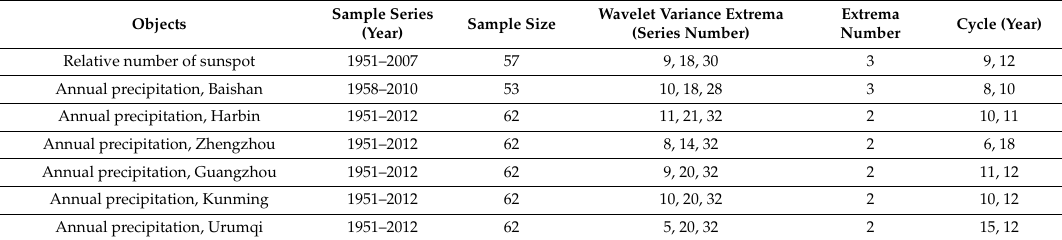
Table 2. Wavelet variance